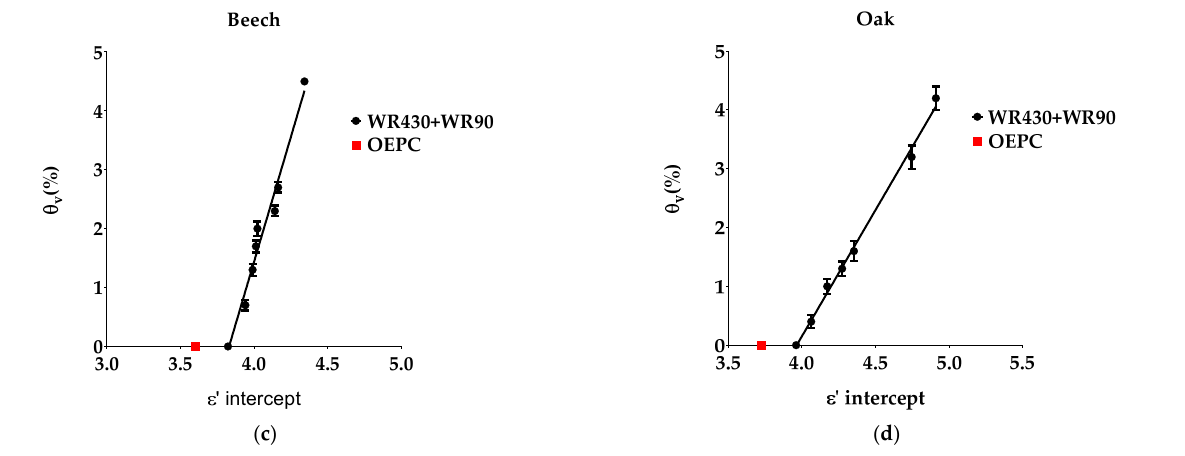
Figure 5. This figure reports the calibration curve based on the relationship between the vertical shift b of the log-fit equation and the different θ v (%) levels: ( a ) fir, ( b ) poplar, ( c ) beech, ( d ) oak. Measurements were conducted with WR-430 and WR-90 waveguides. In red, the OEPC measurements at dry condition were highlighted.